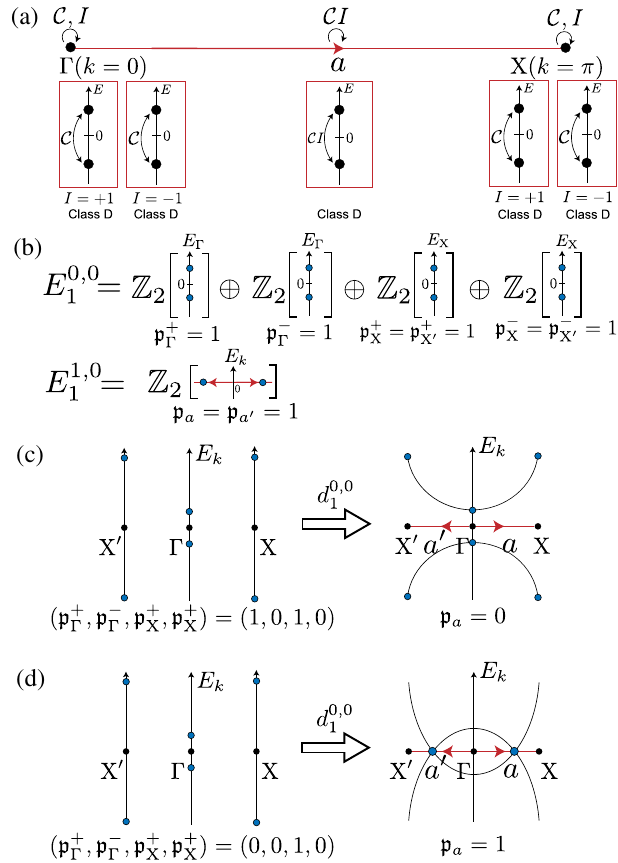
FIG. 7. Illustration of the 1D even-parity superconductors. (a) An asymmetric unit of BZ and EAZ classes for cells in F 0 ¼ f Γ ; X g and F 1 ¼ f a g . Here, the red arrows signify orientations of the 1-cell. (b) Illustrative description of E 0 ; 0 1 and E 1 ; 0 1 . The entries in brackets represent the band structures of generators. (c),(d) The physical process of d 0 ; 0 1 . For the system with ð p þ Γ ; p − Γ ; p þ ð 1 ; 0 ; 1 ; 0 Þ , d 0 ; 0 1 does not generate a gapless point on the 1-cells [(c)]. On the other hand, for the system with ð p þ Γ ; p − Γ ; p þ ð 0 ; 0 ; 1 ; 0 Þ , d 0 ; 0 1 there exists a gapless point on each 1-cell [(d)].